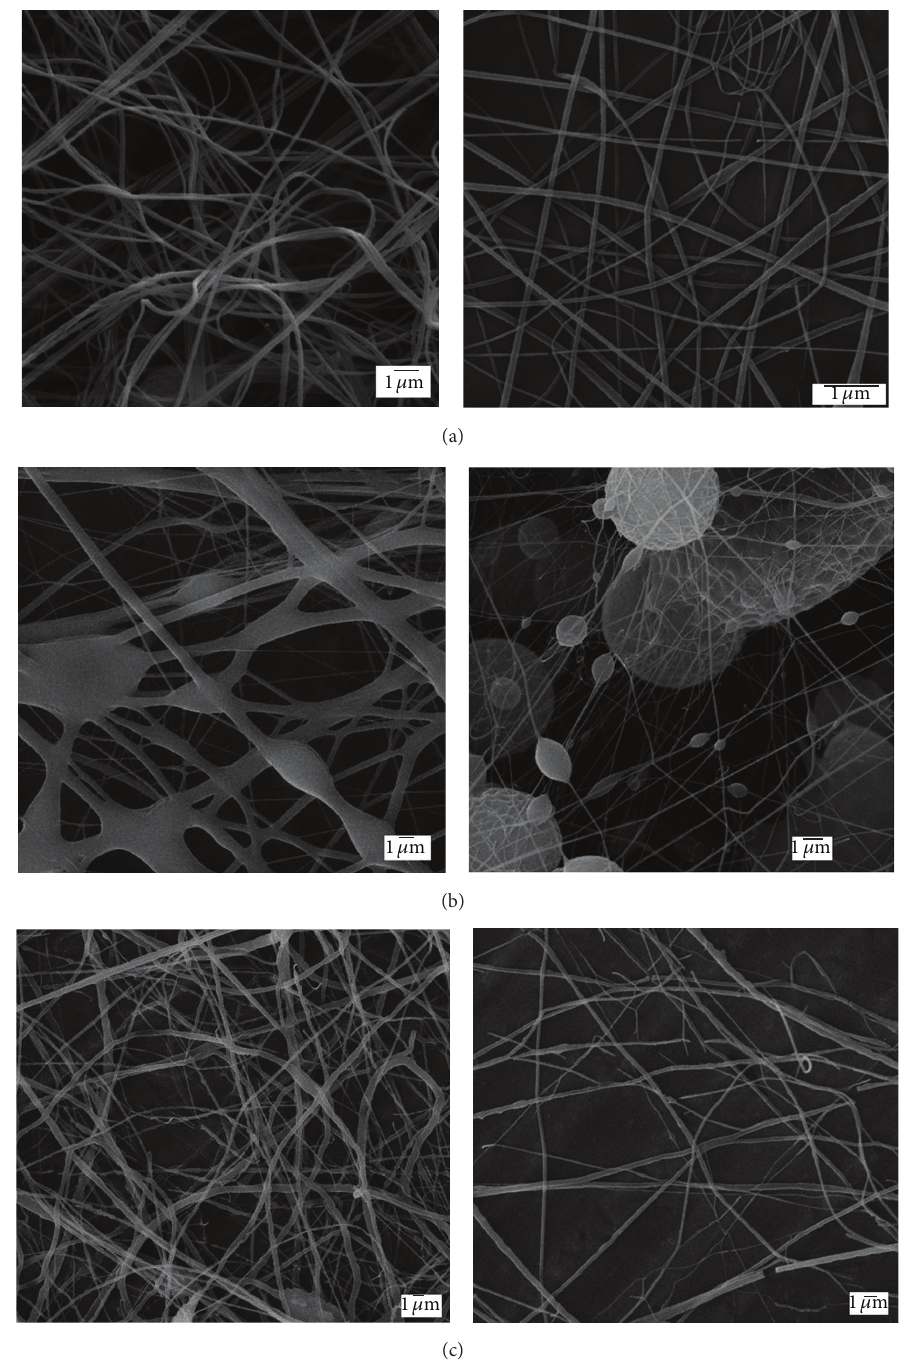
Figure 2: Scanning electron micrographs of spun fibers obtained by solution blow spinning and electrospinning for PLA (a), PCL (b), and PEO (c). Right side: electrospun and left: